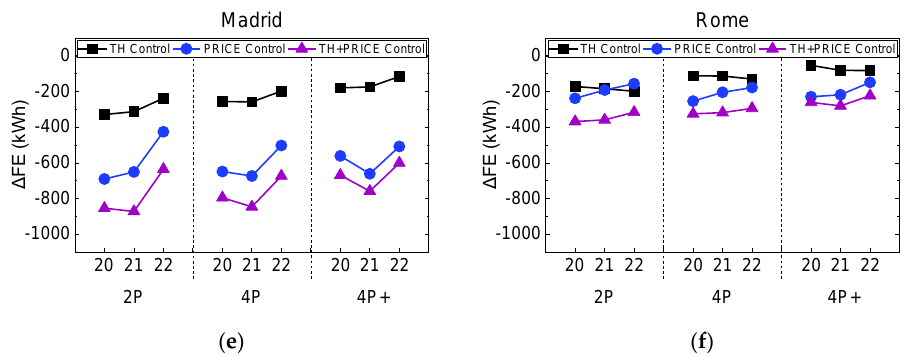
Figure 7. Change in final energy (ΔFE) due to the advanced control algorithms for the small PV system with battery for the full range of boundary conditions: country, appliance use (2P, 4P, and 4P+) and room set temperature (20, 21, and 22 °C). ( a )–( f ) shows the ΔFE respectively for each of the six examined locations.